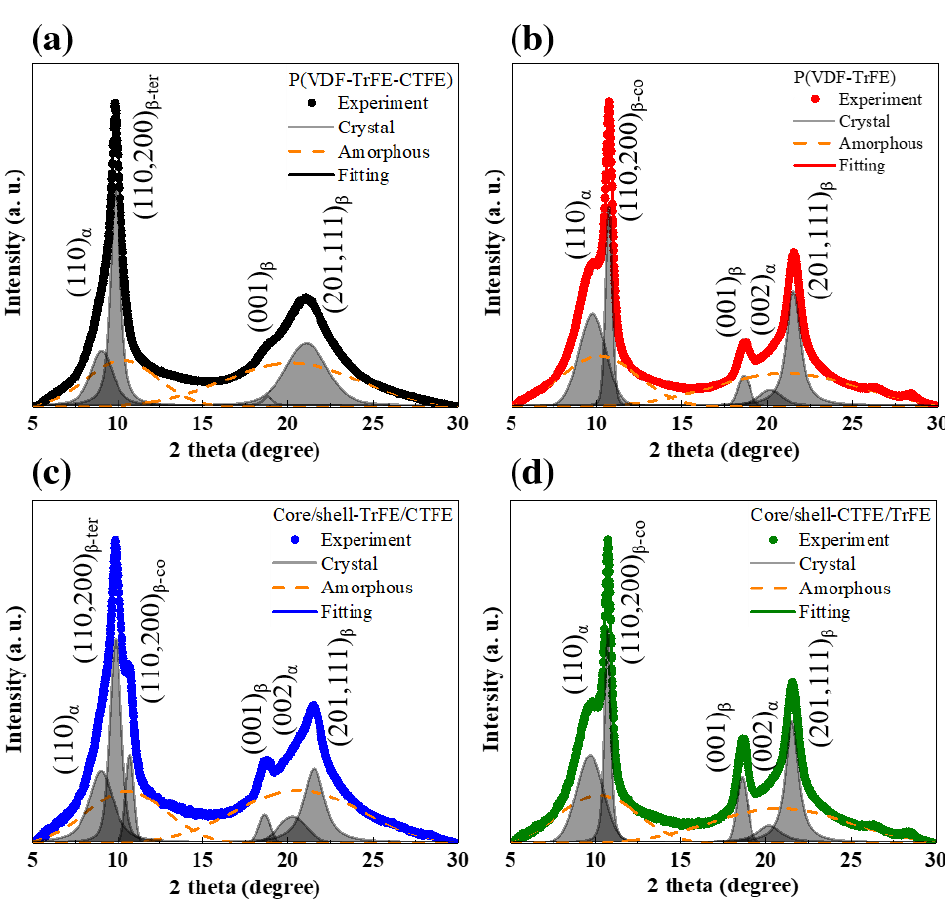
Figure 6. The 1D WAXD intensity profiles and corresponding peak fitting in the ( a ) pristine P(VDF-TrFE-CTFE), ( b ) pristine P(VDF-TrFE), ( c ) core/shell-TrFE/CTFE, and ( d ) core/shell-CTFE/TrFE.